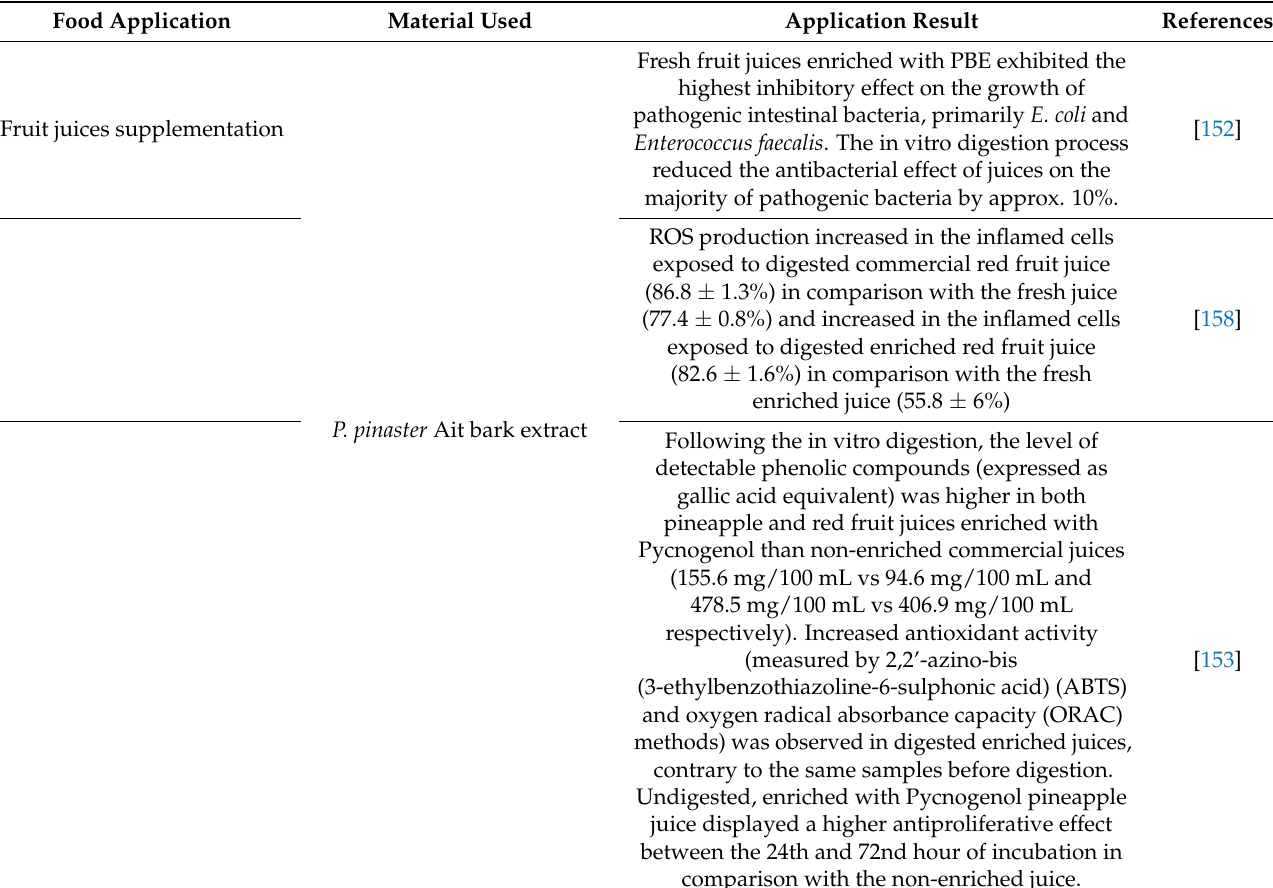
Table 9. Application of Pinus in food